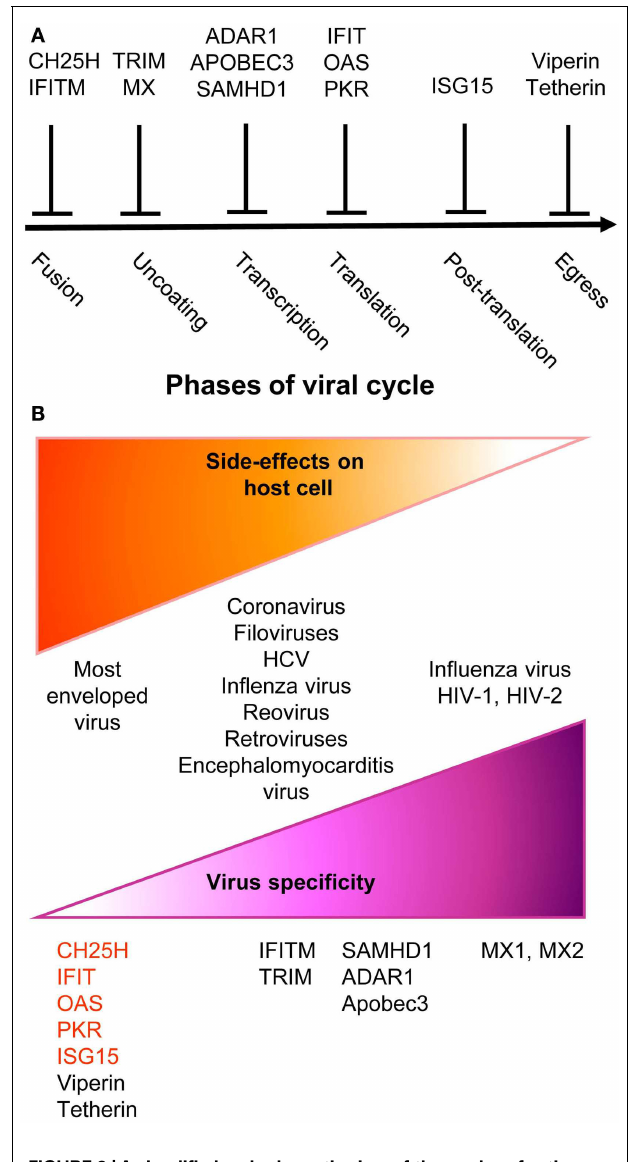
FIGURE 2 |A simplified and schematic view of the modes of action and specificities of ISG acting as direct anti-viral restriction factors . (A) Different IFN-inducible restriction factors can block viral replication in infected cells in a cell-intrinsic manner at different stages of the viral life cycle. (B) Viral specificity (purple) might be inversely correlated to the breadth of side effects on host cells